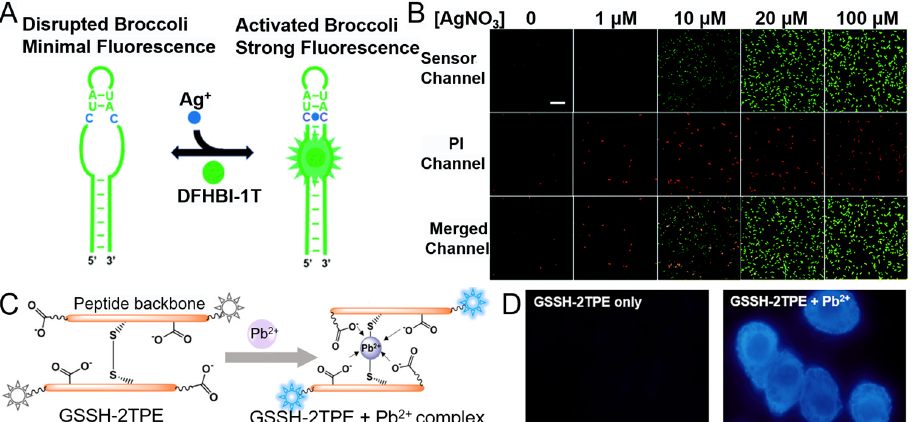
Figure 9. Two representative examples of non-essential metal ion detection in living cells: ( A ) Sche- matic illustration of modified Broccoli. The green region indicates sequences from the original Broc- coli and the C–C mismatch is highlighted in blue. ( B ) Confocal fluorescence imaging of the sensor- expressing BL21 (DE3) * cells. Reproduced from [136] with permission from the Royal Society of Chemistry, copyright 2019. ( C ) Possible process for the formation of the coordination complex and supramolecular assembling of fluorescent nanoaggregates from GSSH-2TPE and Pb 2+ . ( D ) Fluores- cence microscopic images of living HeLa cells with GSSH-2TPE, with and without the addition of Pb 2+ . Reproduced from [144] with permission from the American Chemical Society, copyright 2019.